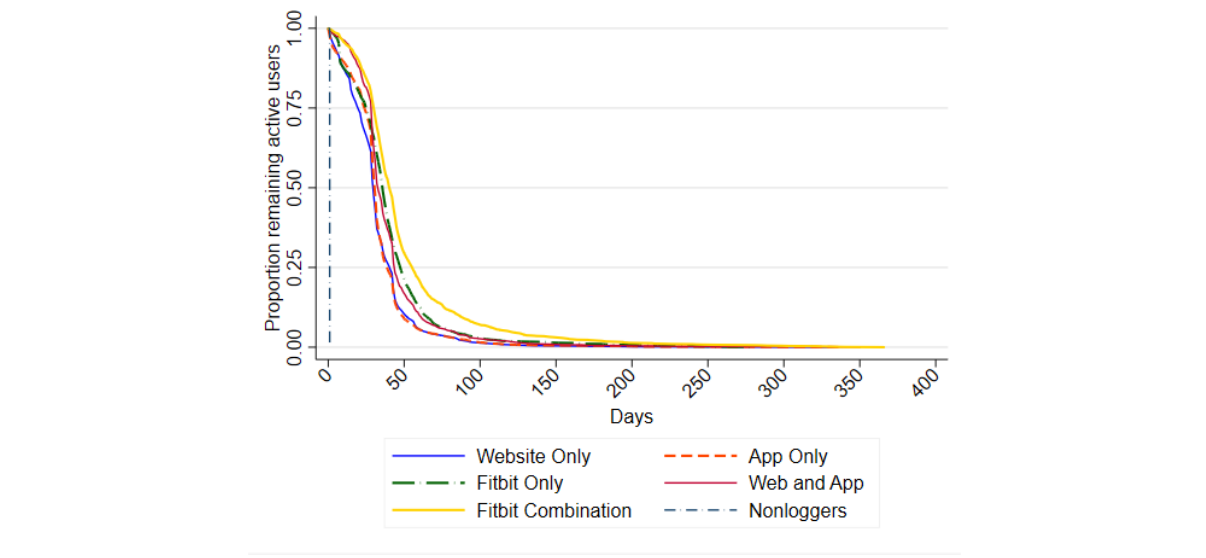
Figure 2. Kaplan-Meier estimates of the survival distribution for time to nonusage attrition by group.